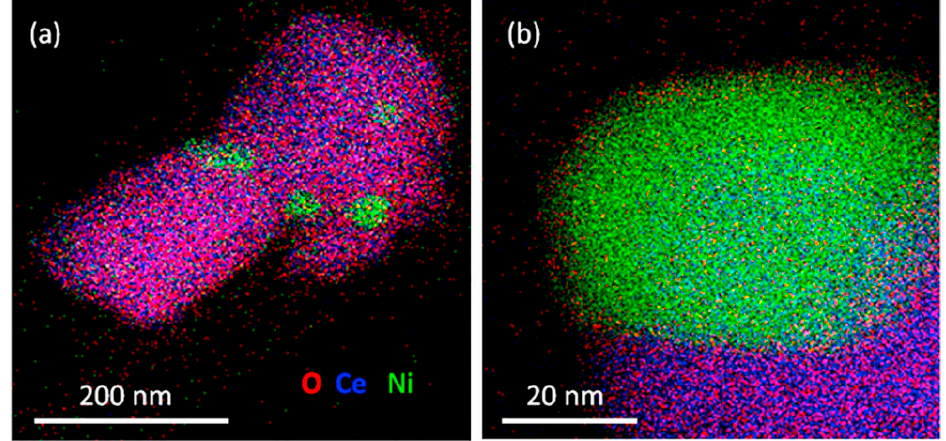
Figure 6. ( a ) low and ( b ) high magnification STEM-EDX elemental display of Ni/CeO 2 exsolved from Ce 0.97 Ni 0.33 O 2 - δ after 90 h of DRM at 800 °C. Figure republished with permission from [95]. Copyright Elsevier, 2020.